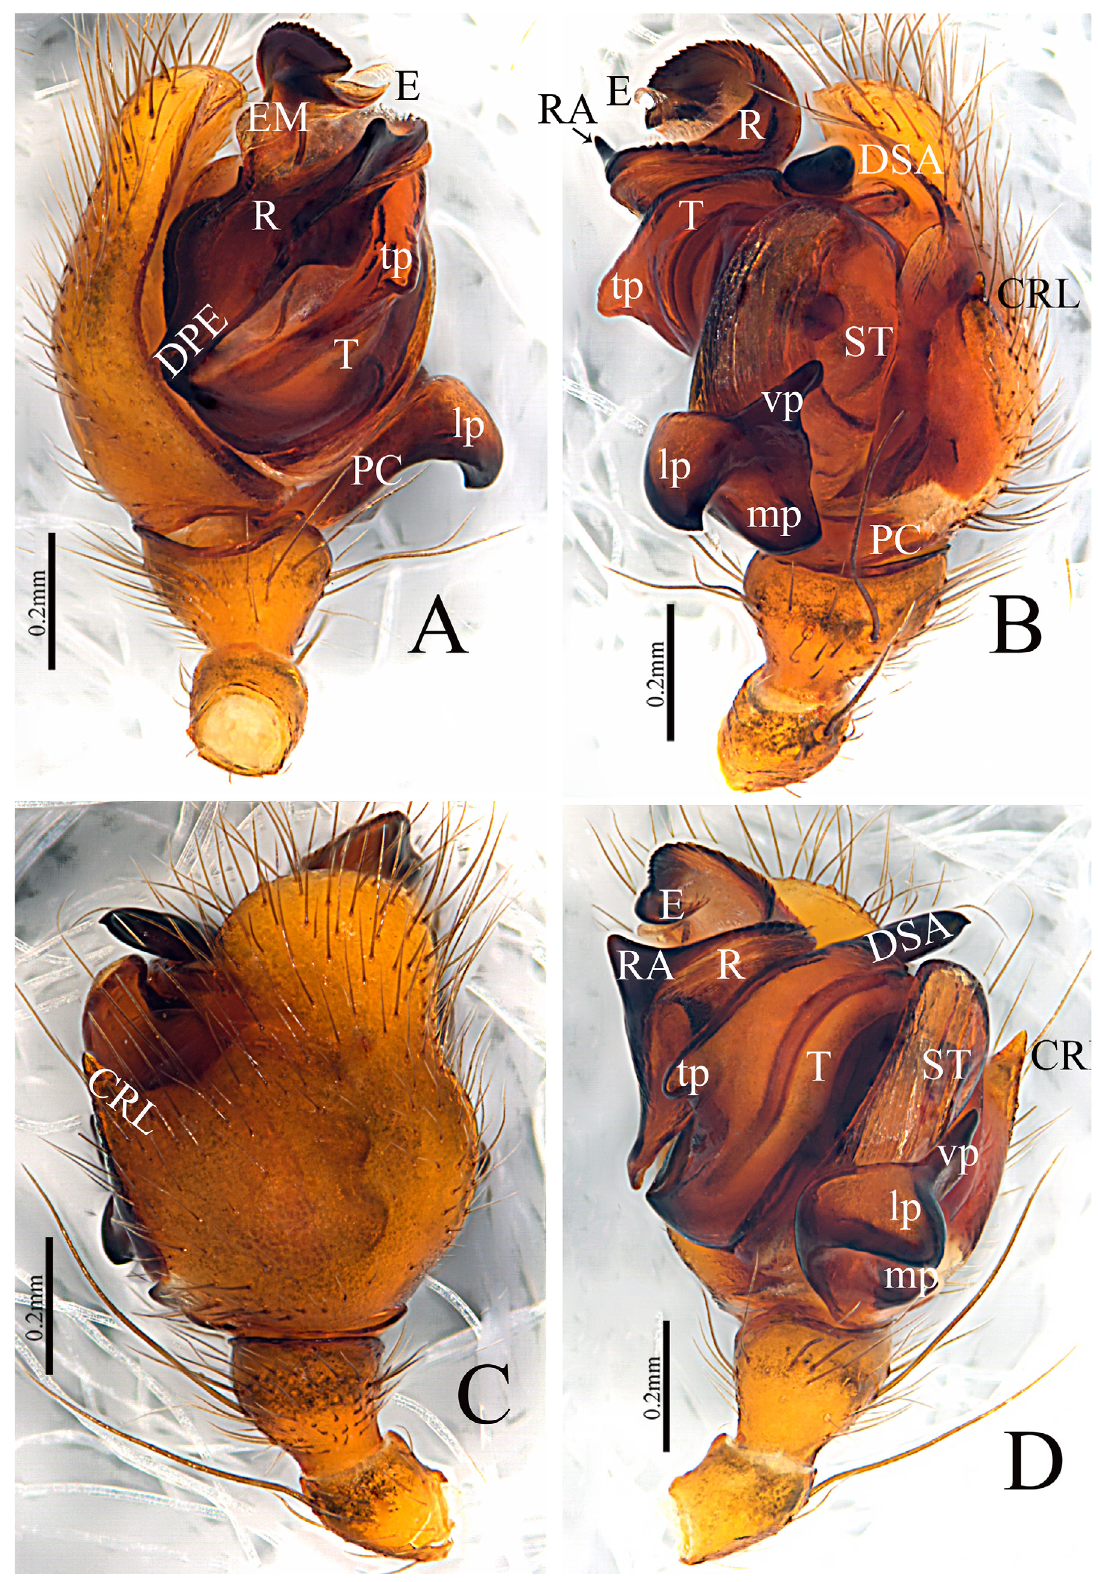
Fig. 6. Acroterius brevis gen. et sp. nov., ♂, holotype (HNU-20040501–1), palp. A . Prolateral view. B . Retrolateral view. C . Dorsal view. D . Ventral